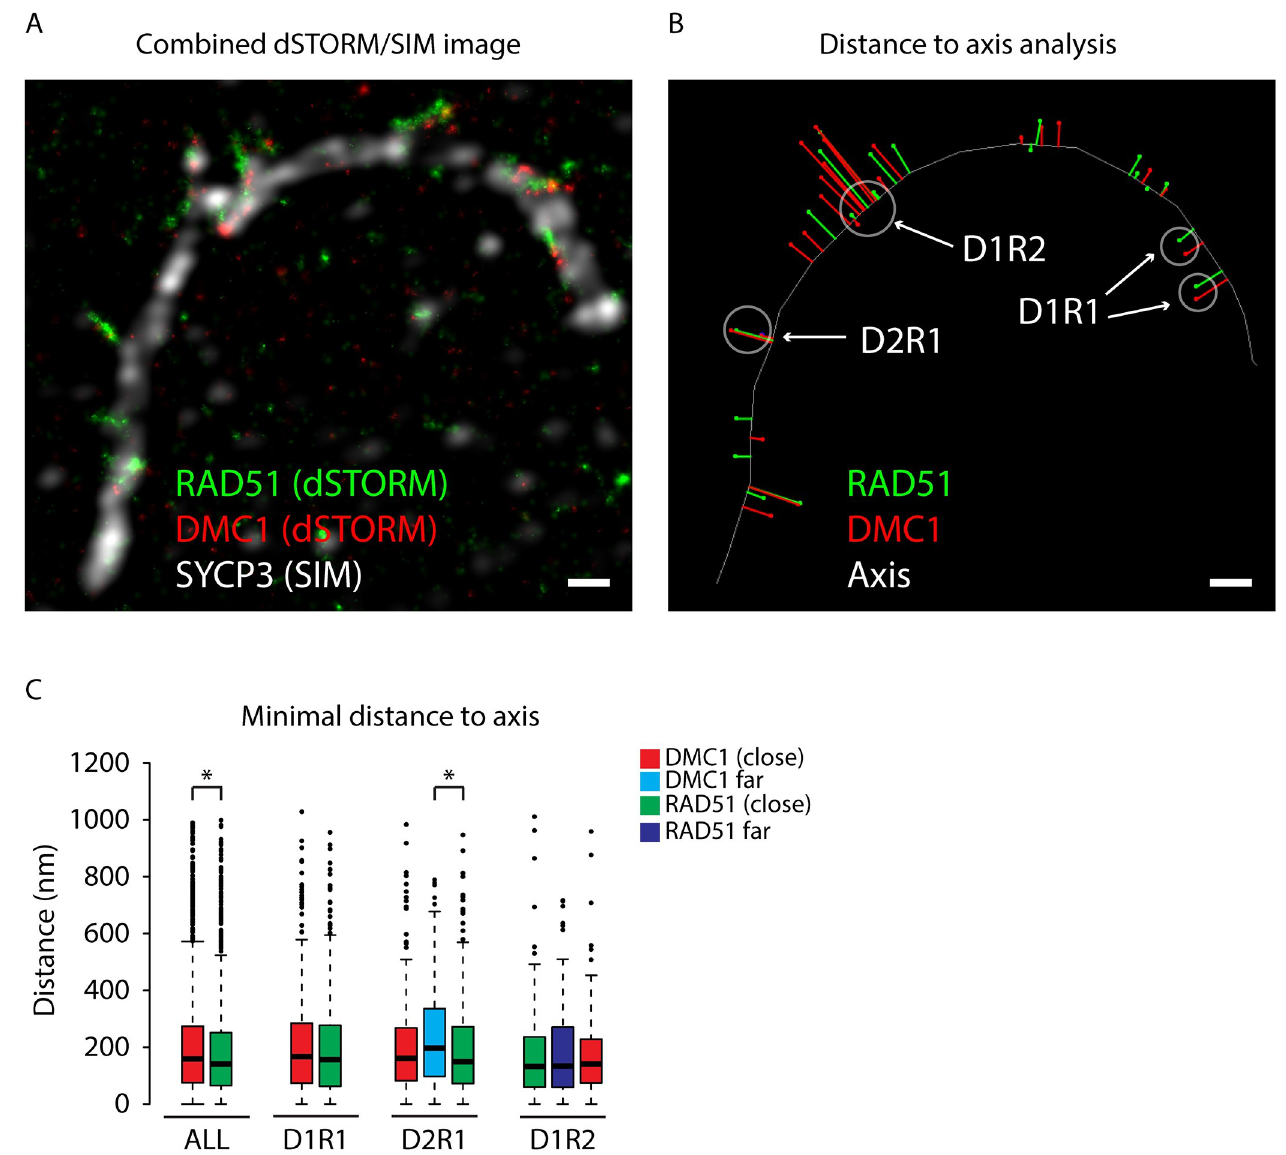
Fig 6. Distance of RAD51 and DMC1 nanofoci to the axial and lateral elements of the SC. A) Combined dSTORM and SIM image of a segment from a synapsed pachytene nucleus immunostained for RAD51 (green), DMC1 (red), and SYCP3 (white). B) The same area of the nucleus is shown, but here the immunosignals have been replaced by a line for SYCP3, and by dots indicating the centers of mass for RAD51 (green) and DMC1 (red). The red and green lines represent the measured distances. An example of regions where nanofoci distances were measured for D1R1, D1R2, and D2R1 foci are indicated (note that distances from another more complex ROI intersperse with the D1R2 distances). Size bars represent 500 nm. C) Box plots of minimal distances (nm) of all RAD51 and DMC1 nanofoci as well as the distances of the nanofoci of the separate D1R1, D2R1, and D1R2 classes to the axial or lateral elements in zygotene and pachytene nuclei, colour code explained in the figure. Asterisks indicate statistical significant differences, p-values are in S2 Table, the boxed region depicts the data from the first quartile to the third quartile and the whiskers extend +/- 1.5x the interquartile range (IQR = Q3-Q1; minimum value = 0). Data points lying outside this region are depicted as individual points (outliers). All DMC1 n = 1606, all RAD51 n = 2141, D1R1 n = 421, D2R1 n = 265, D1R2 n =